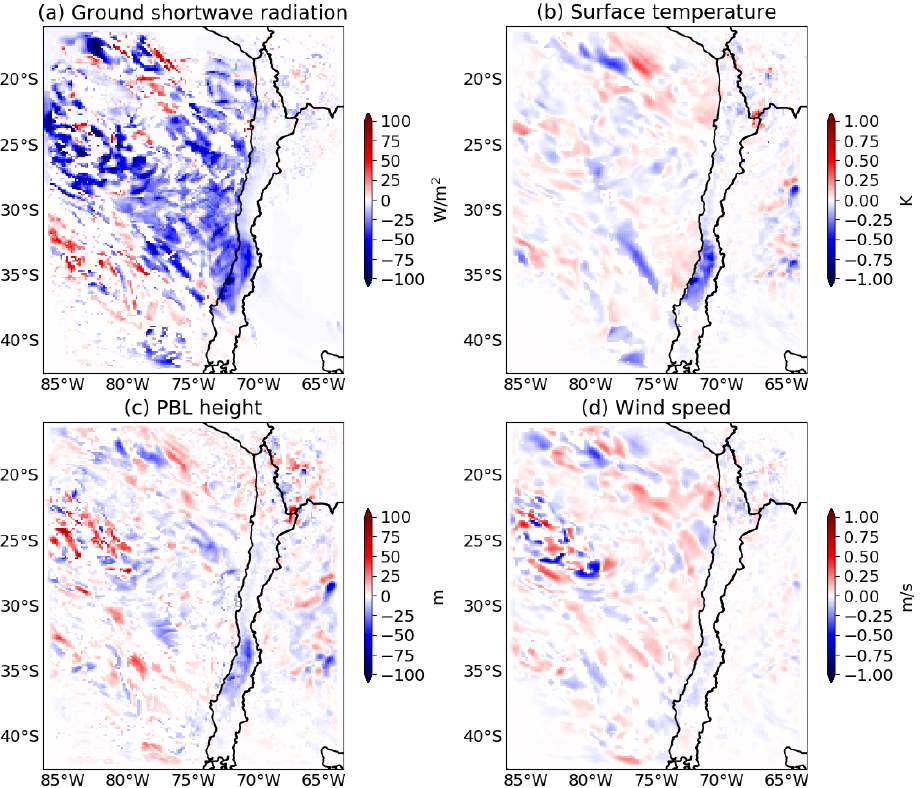
Figure 8. Effect of fire emissions on ( a ) surface shortwave radiation, ( b ) planetary boundary layer height, ( c ) surface air temperature, ( d ) 10m wind speed. Difference between the fire case and control case. Average for 26–29 January. Only grid points where the distribution of concentrations in the fire case is different than in the control case at the 99% level, based on a Wilcoxon test, are